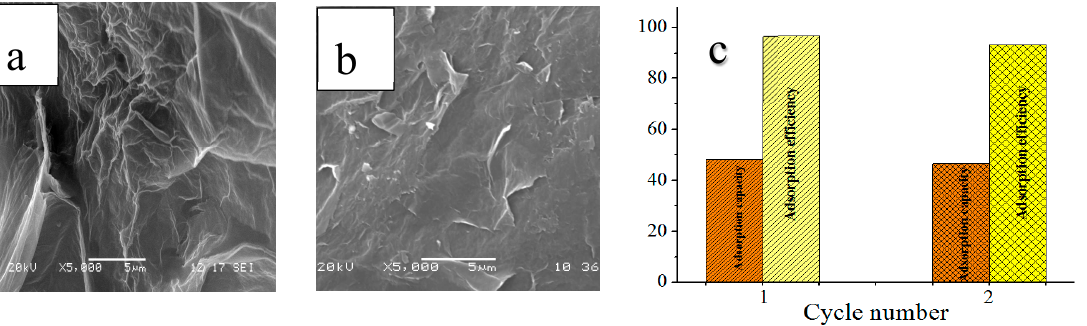
Figure 9. ( a ) SEM image of CS / GO aerogel before adsorption. ( b ) SEM image of CS / GO aerogel after desorption. ( c ) The e ff ect of readsorption after desorption.